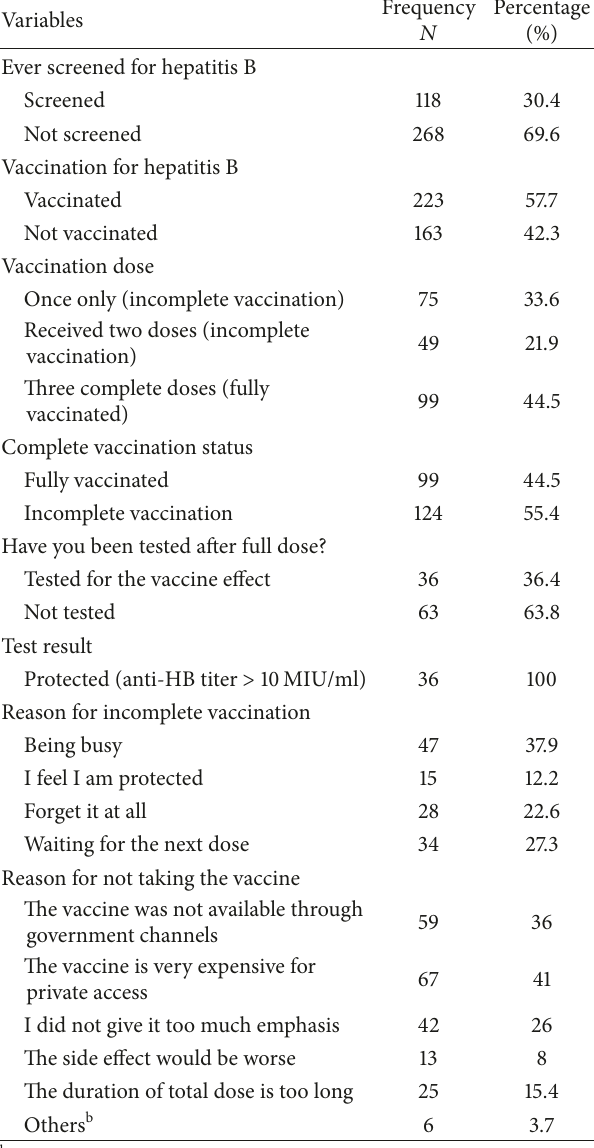
Table 4: Vaccination status and reason for not taking the vaccine among health professionals, AHMC, Ethiopia, in